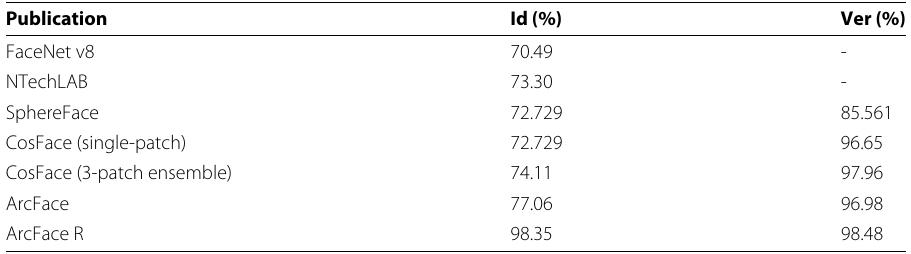
Table 5 Face identification and verification evaluation of different methods on MegaFace Challenge1 using FaceScrub as the probe